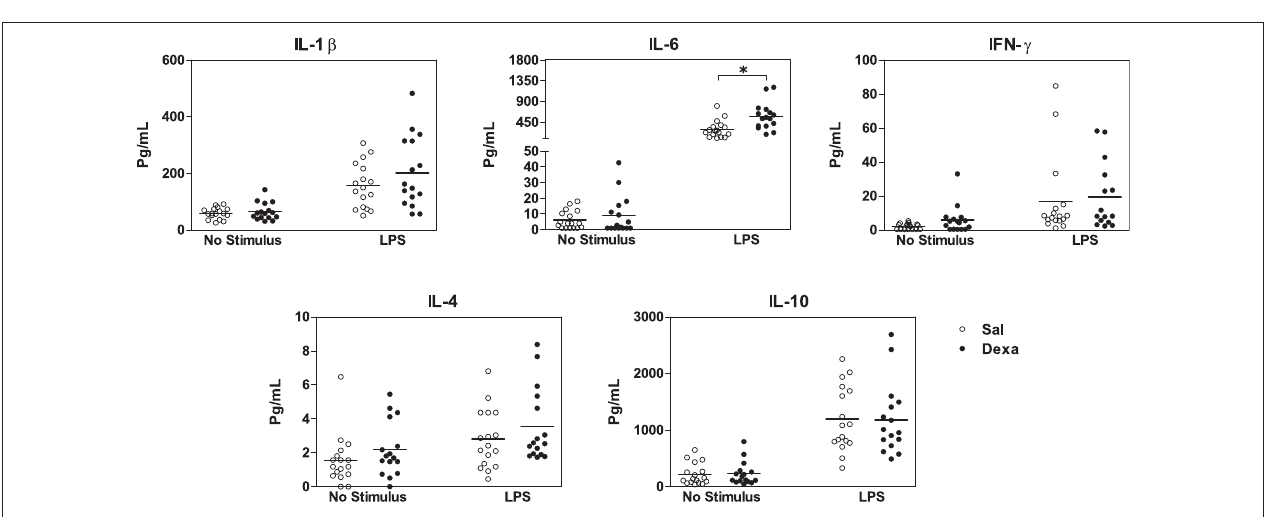
FIgure 4 | Prenatal treatment with dexamethasone induces a decrease in adult serum IL-6 and IL-10 levels. Serum IL-1 β , IL-6, IFN- γ , IL-4, and IL-10 concentrations were determined using a multiplex cytokine assay. Each point represents one rat and the line corresponds to the mean of 12–13 rats per group from two independent experiments. DL, detection limit.